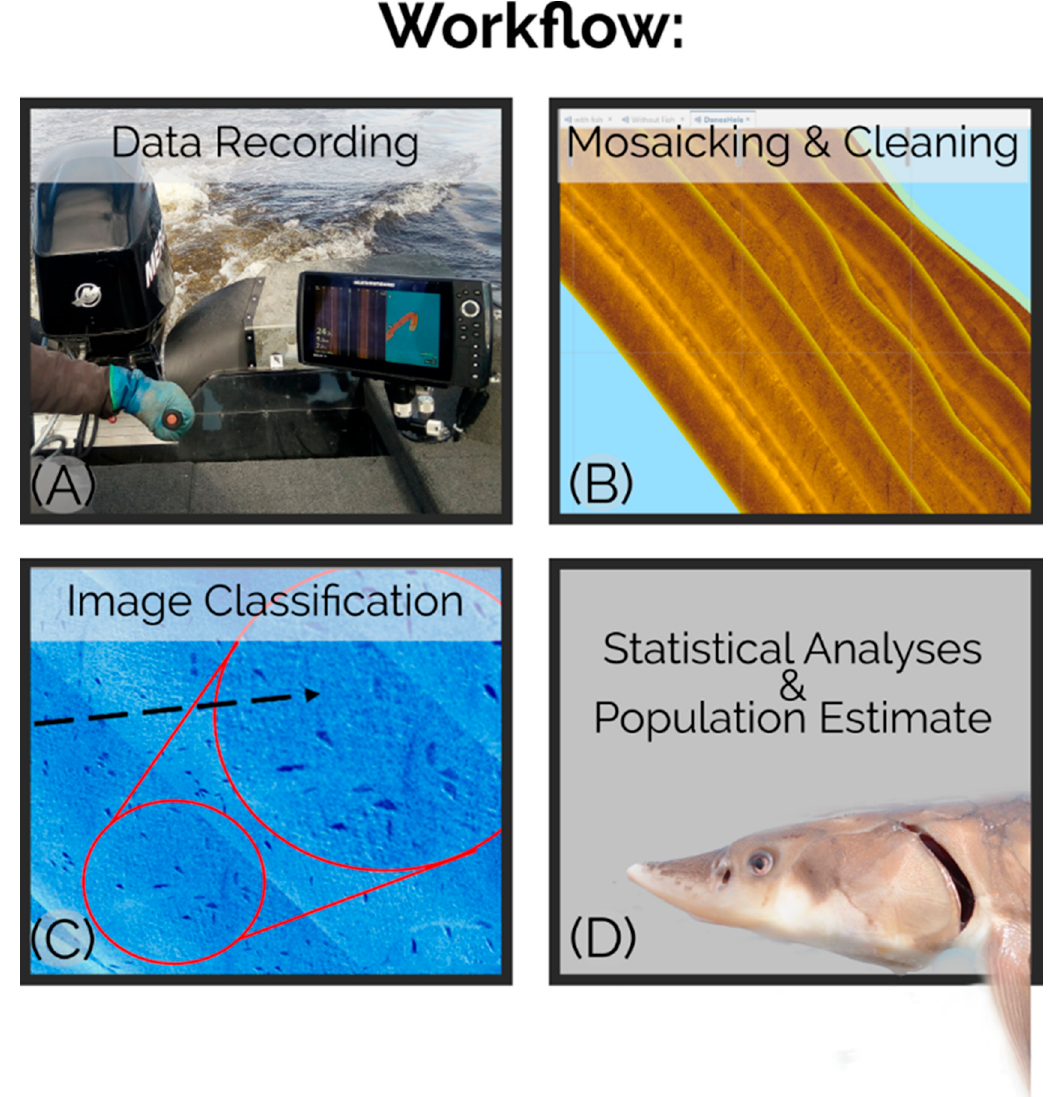
Figure 2. Project workflow diagram including ( A ) collection of side-scan imagery, ( B ) mosaicking and cleaning of side-scan data, ( C ) Image classification of Sturgeon and non-Sturgeon returns, and ( D ) statistical analysis and population estimate from acoustic tracking data.